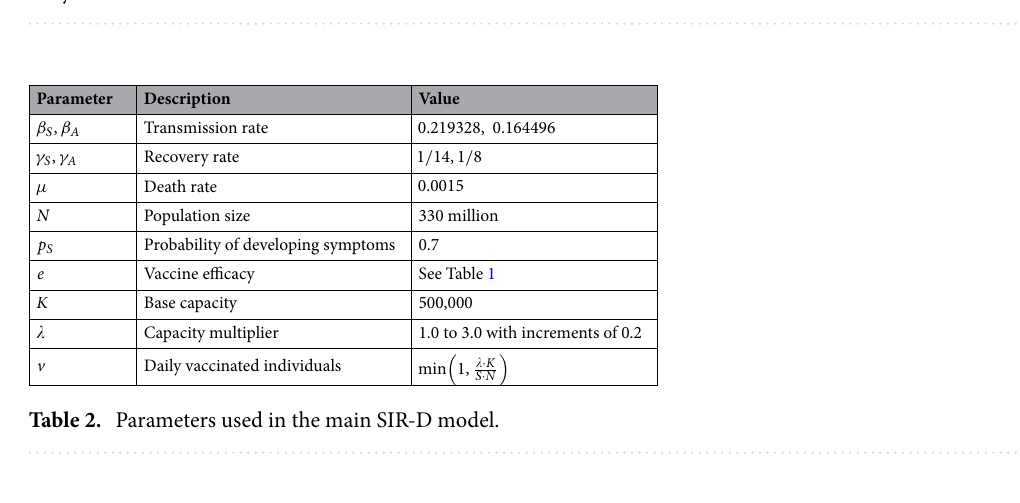
Figure 1. Transition diagram of the main SIR-D model, in which each move is dependent on various parameters. β S , β A : symptomatic and asymptomatic transmission rates, respectively; γ S , γ A : symptomatic and asymptomatic recovery rates, respectively; μ: decease rate of a symptomatic patient; e : efficacy of the vaccine; v : daily vaccinated.